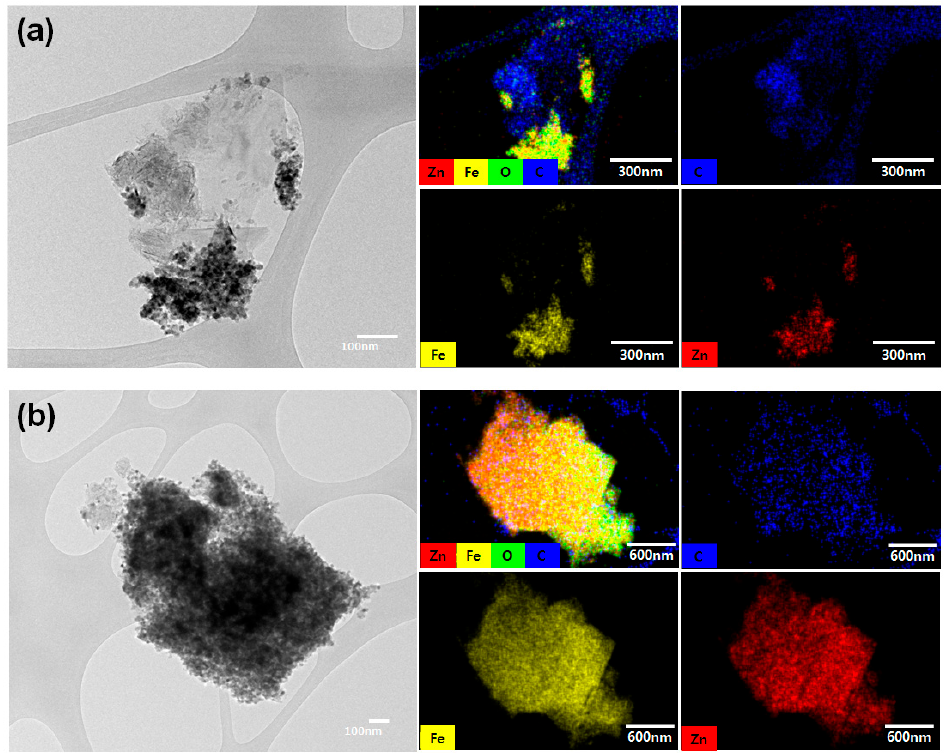
Figure 4. TEM images and elemental map of ( a ) ZFO–G; ( b )